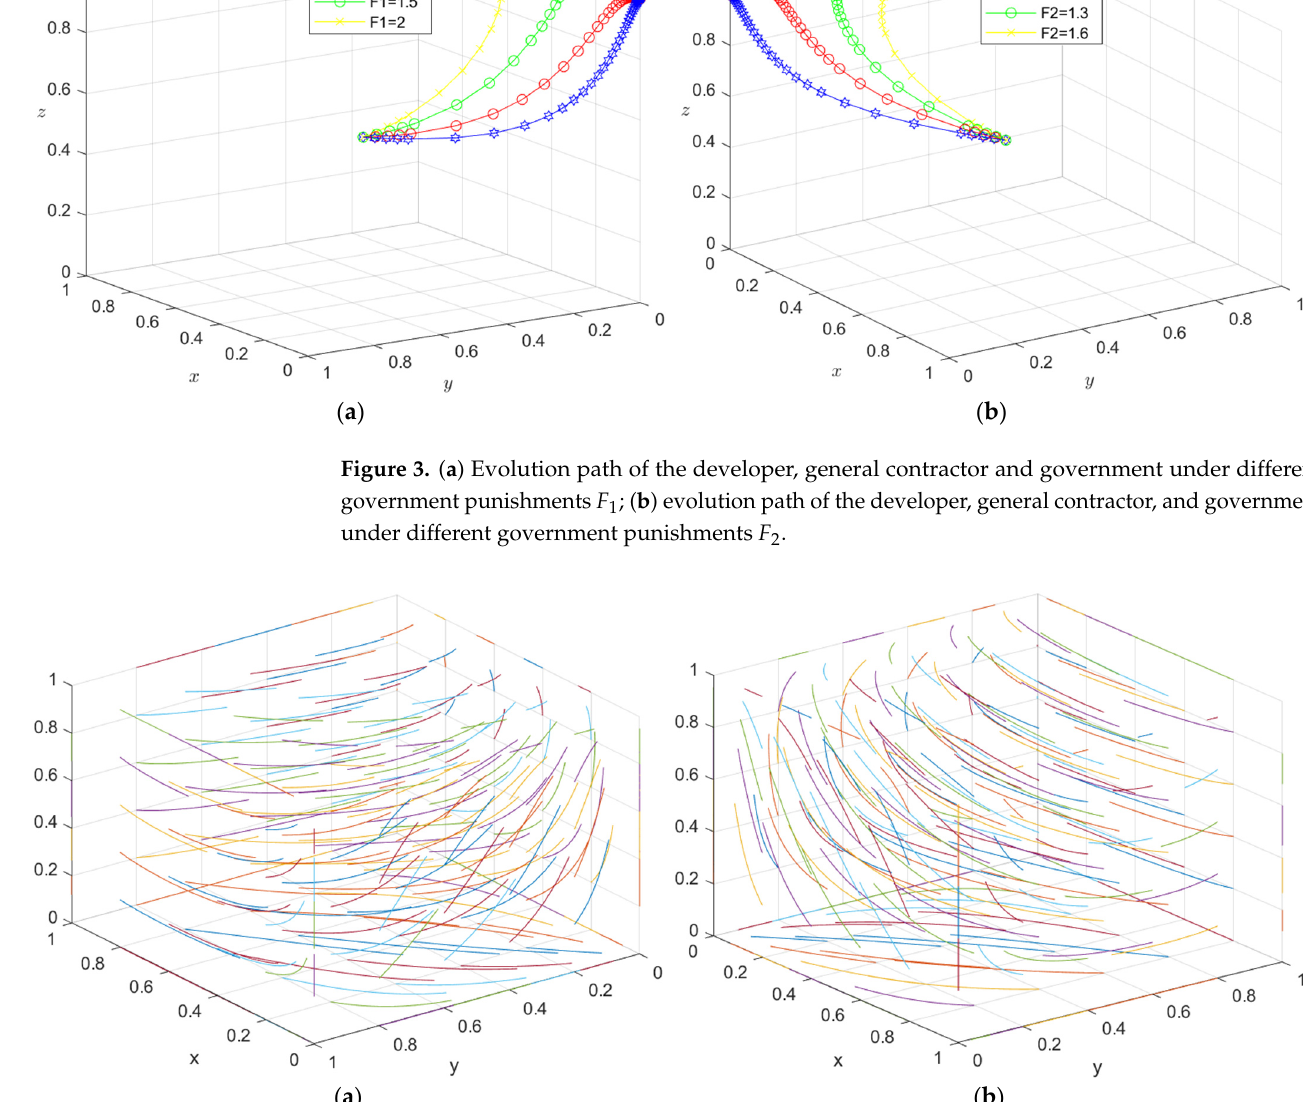
Figure 4. ( a ) Evolution of developers, general contractors, and governments. Parameters: x = 0.5, θ = 0.4, I 1 = 10, I 2 = 8, C 1 = 5, C 2 = 4, E 1 = 3, E 2 = 3, E 3 = 1.8, E 4 = 1.3, D 1 = 2.5, D 2 = 2.4, S 1 =